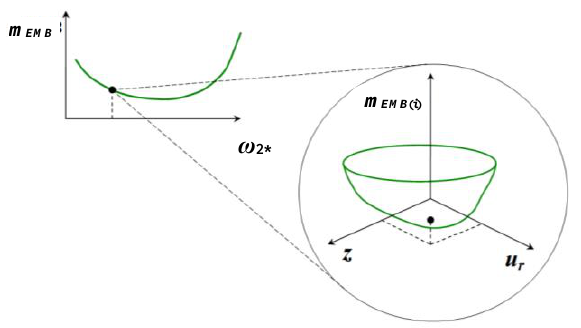
Fig. 3. m EMB curve and i -number calculation step with m EMB ( i ) curve. For  2 * diapason a step value  2 * = 0.025 is chosen. At each